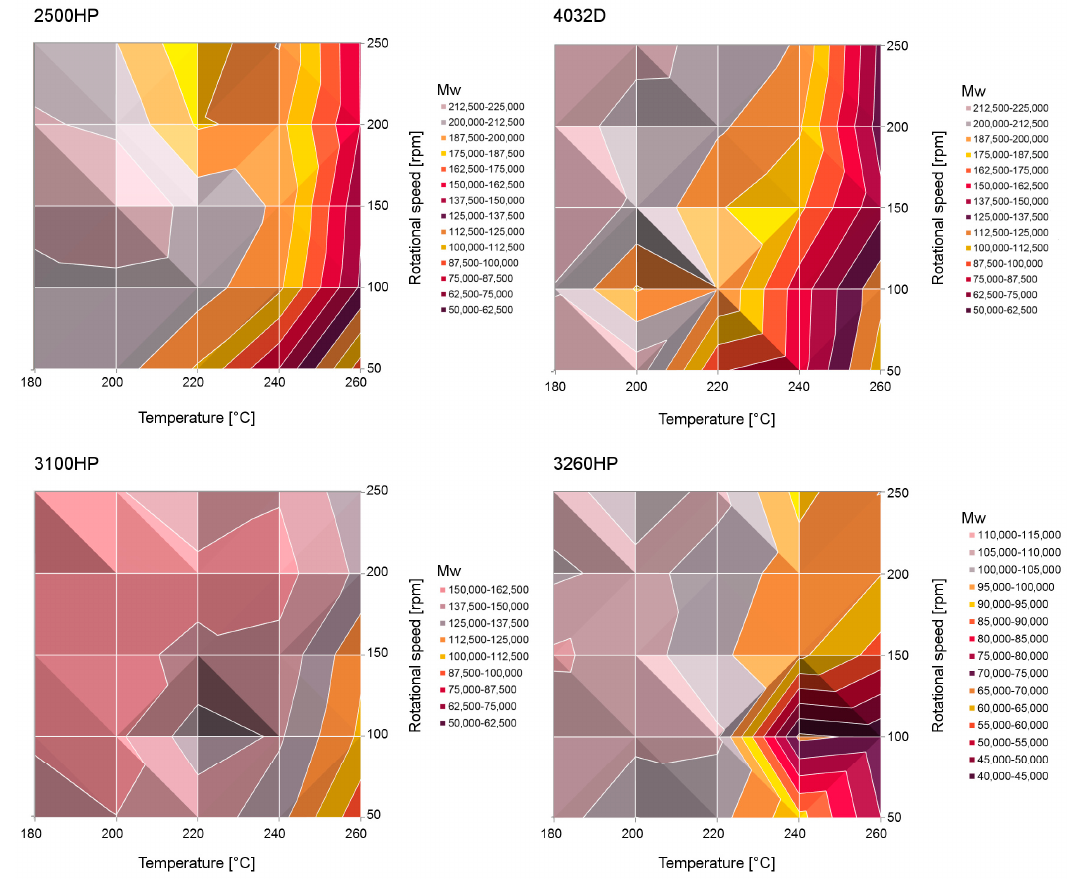
Figure 4. Molecular weights calculated from the rheological data of processed PLA.